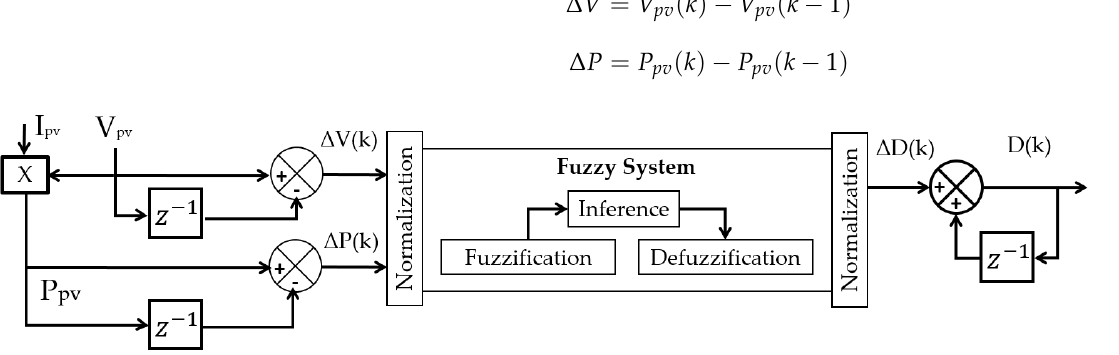
Figure 5. FLC control structure.